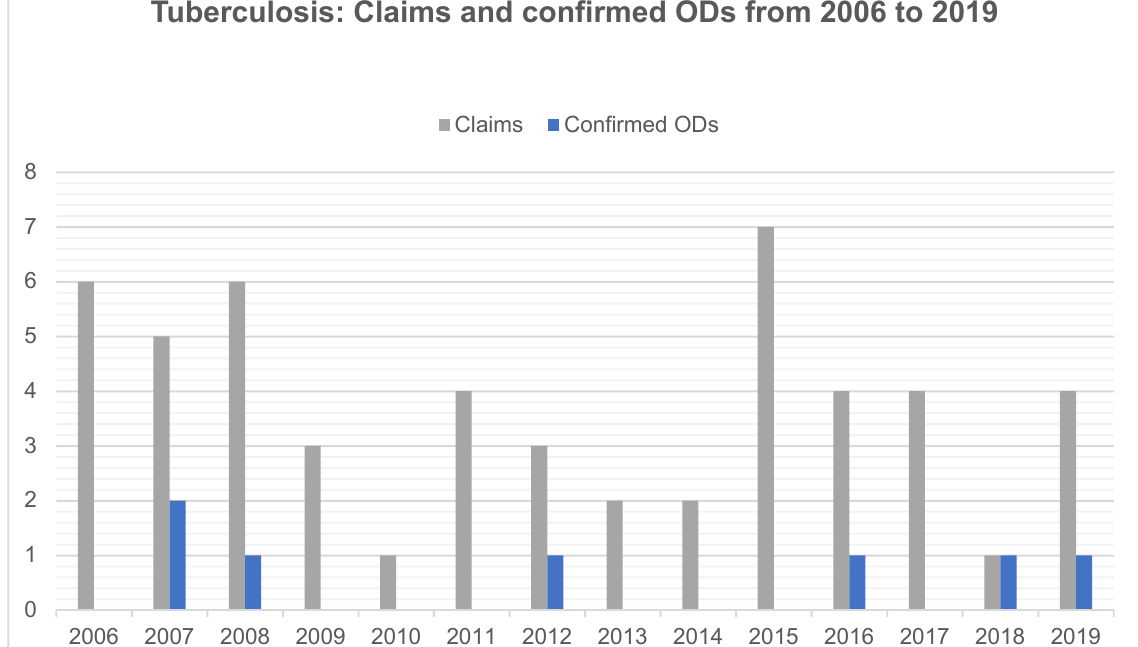
Figure 4. Tuberculosis: Number of claims and confirmed occupational diseases (ODs) among dental health workers from 2006 to 2019.